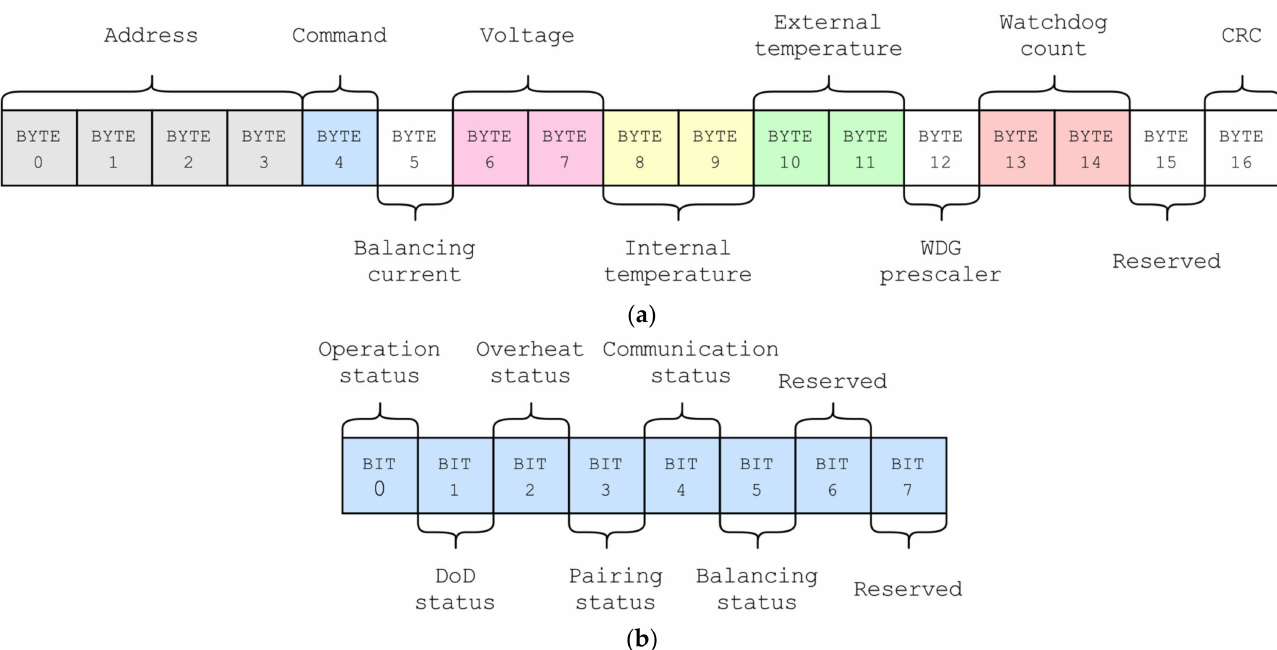
Figure 10. Communication between the MBMS modules: ( a ) the layout of communication frames sent by BMC and SU; ( b ) status flags in the ‘Command’ Byte